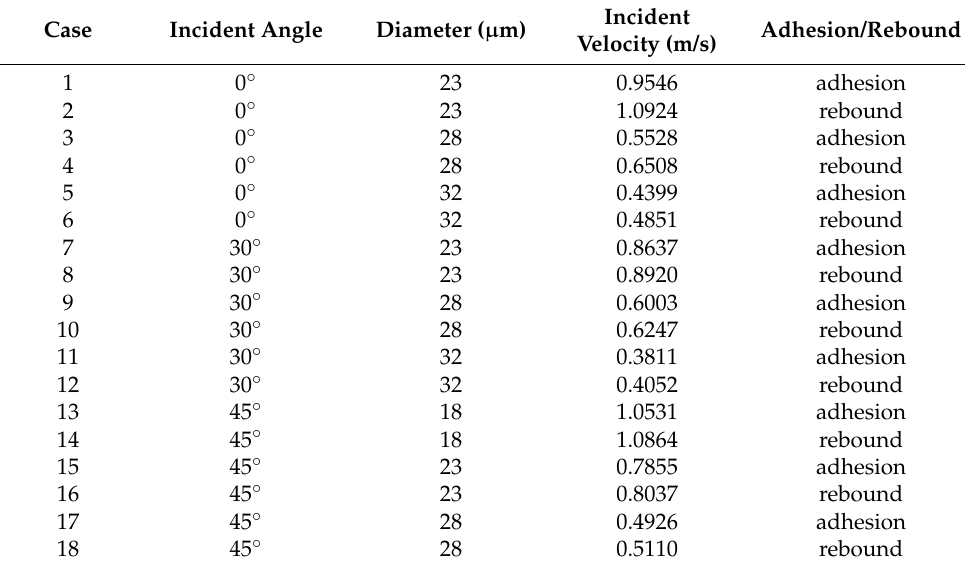
Table 5. The movement behavior of coal ash particles after impacting the stainless steel surface under different working conditions during the